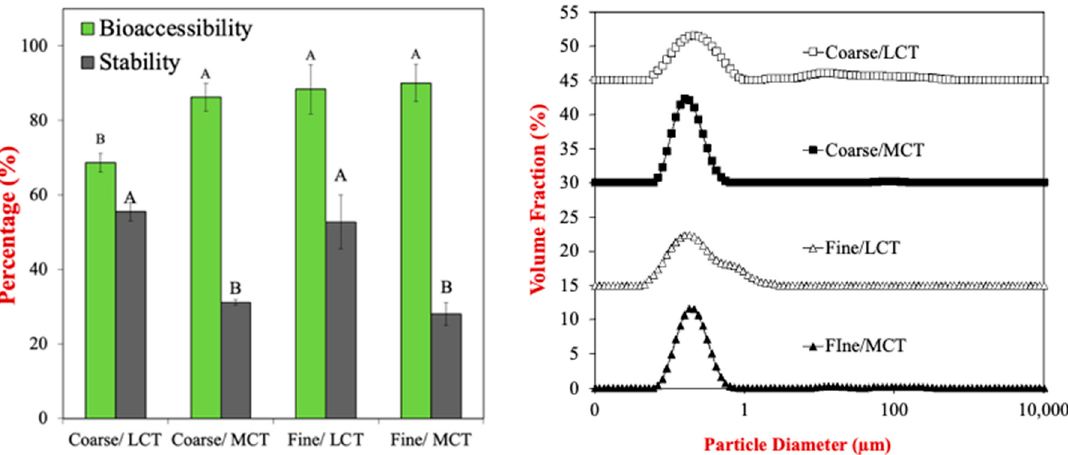
Figure 6. Bioaccessibility and stability of lutein (left) in different plant-based egg analogs and the particle size distribution of the micelle phase (right). Significance differences ( p < 0.05) between sam- ples are labeled with capital letters (A, B). LCT: long chain triglycerides. MCT: medium chain tri- glycerides.